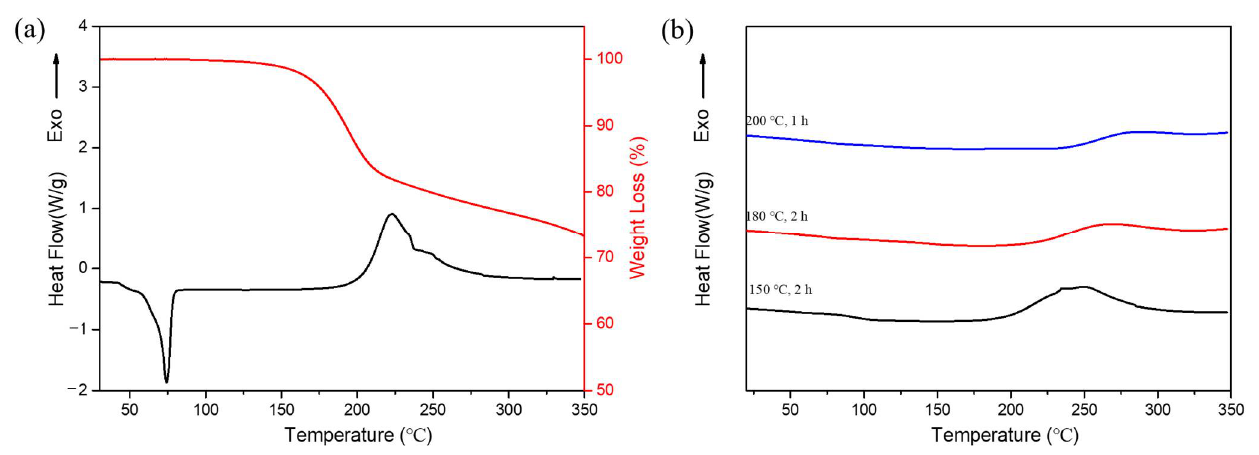
Figure 3. ( a ) Overlay of differential scanning calorimetry (DSC) and TGA–N 2 heating curves of T–Fa precursor. ( b ) DSC heating curves of p(T–Fa) as recorded after step-by-step curing (after being cured at 150 °C for 2 h, 180 °C for 2 h, and 200 °C for 1 h).